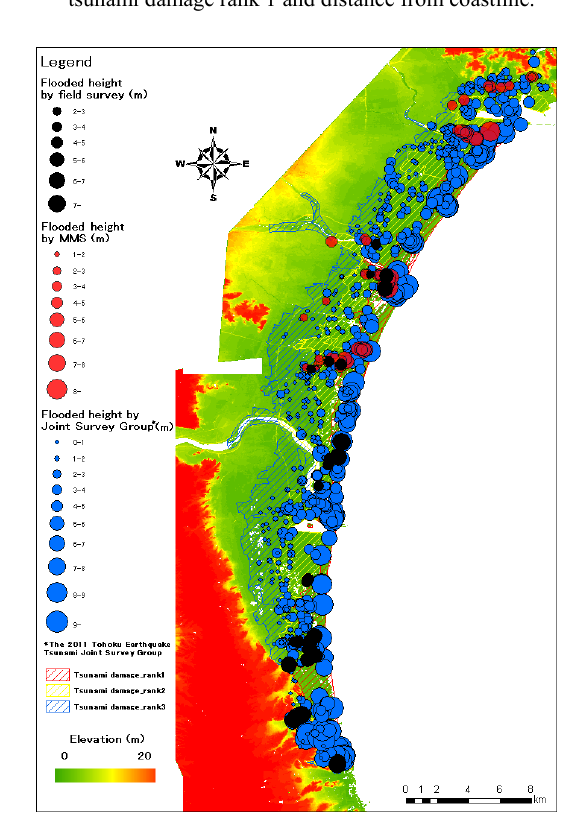
Figure 6. Distribution of tsunami flooded height measured by MMS and other research